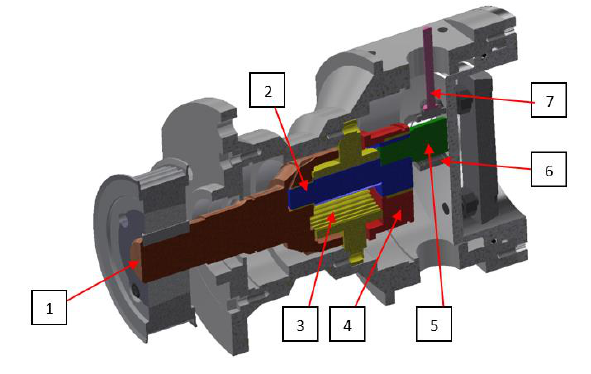
Fig. 3. Simplified model of hypocycloid pump presenting the most im- portant components of the design: 1 – main shaft, 2 – countershaft, 3 –